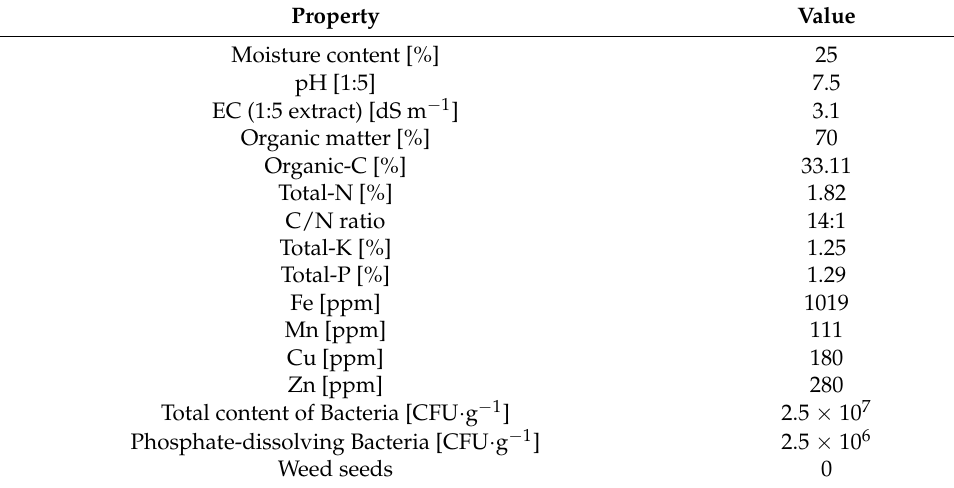
Table 2. Chemical properties of applied organic matter